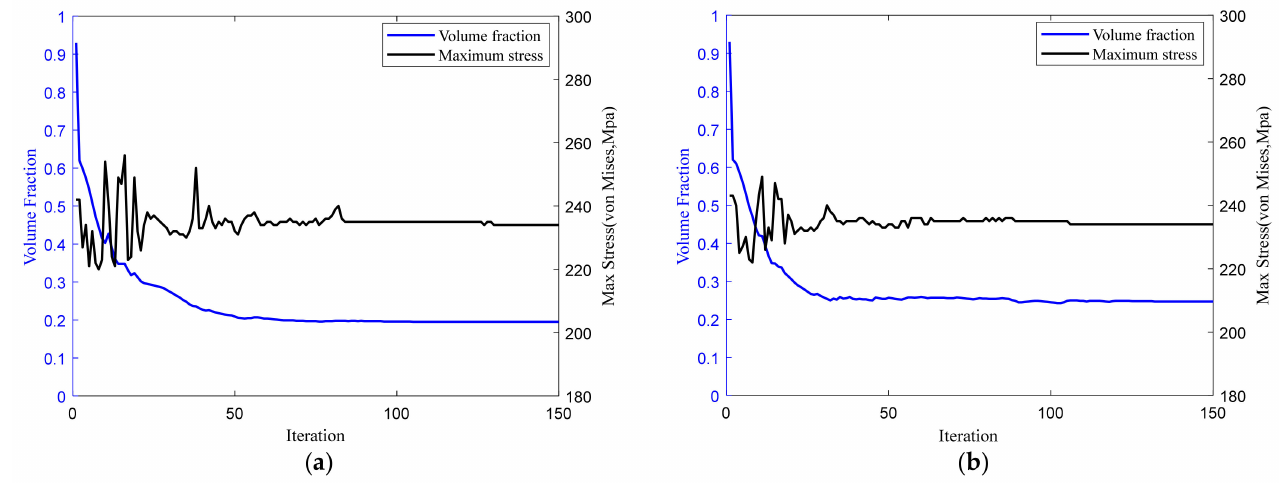
Figure 11. Volume fraction and maximum von Mises stress iteration curves of ( a ) DTO and ( b ) RBTO.